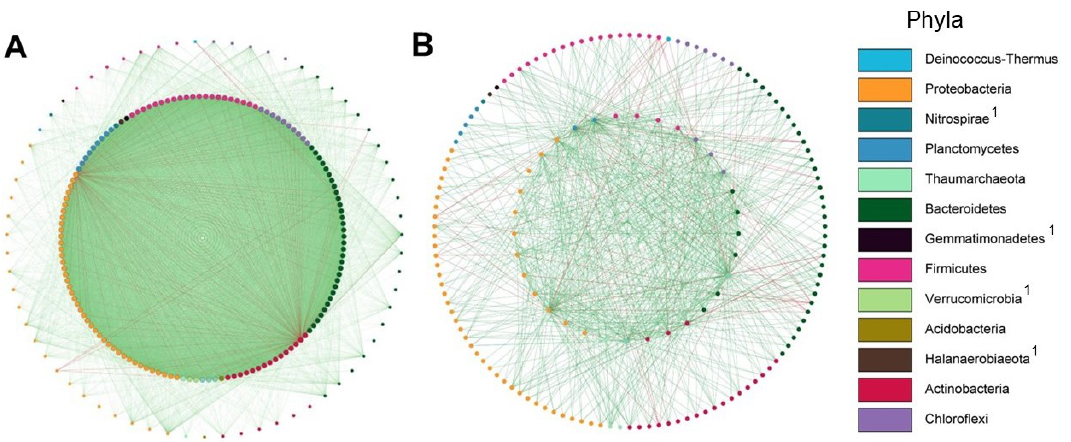
Figure 8. Co-occurrence network analysis: keystone bacterial taxa of the root environment of tomato plants grown in agricultural soil ( A ) and in coconut fiber substrate ( B ). The nodes represent OTUs and the edges represent correlations between and within the keystone taxa nodes and the peripherical taxa nodes. Keystone taxa nodes are depicted as internal to the external peripherical nodes. A connection indicates a statistically significant correlation (FDR adjusted p value < 0.05) with positive correlation values >0.6 (green edges) or < − 0.6 (red edges). Each node color represents an OTU at phylum level. 1 Phyla present only in the soil system as keystone